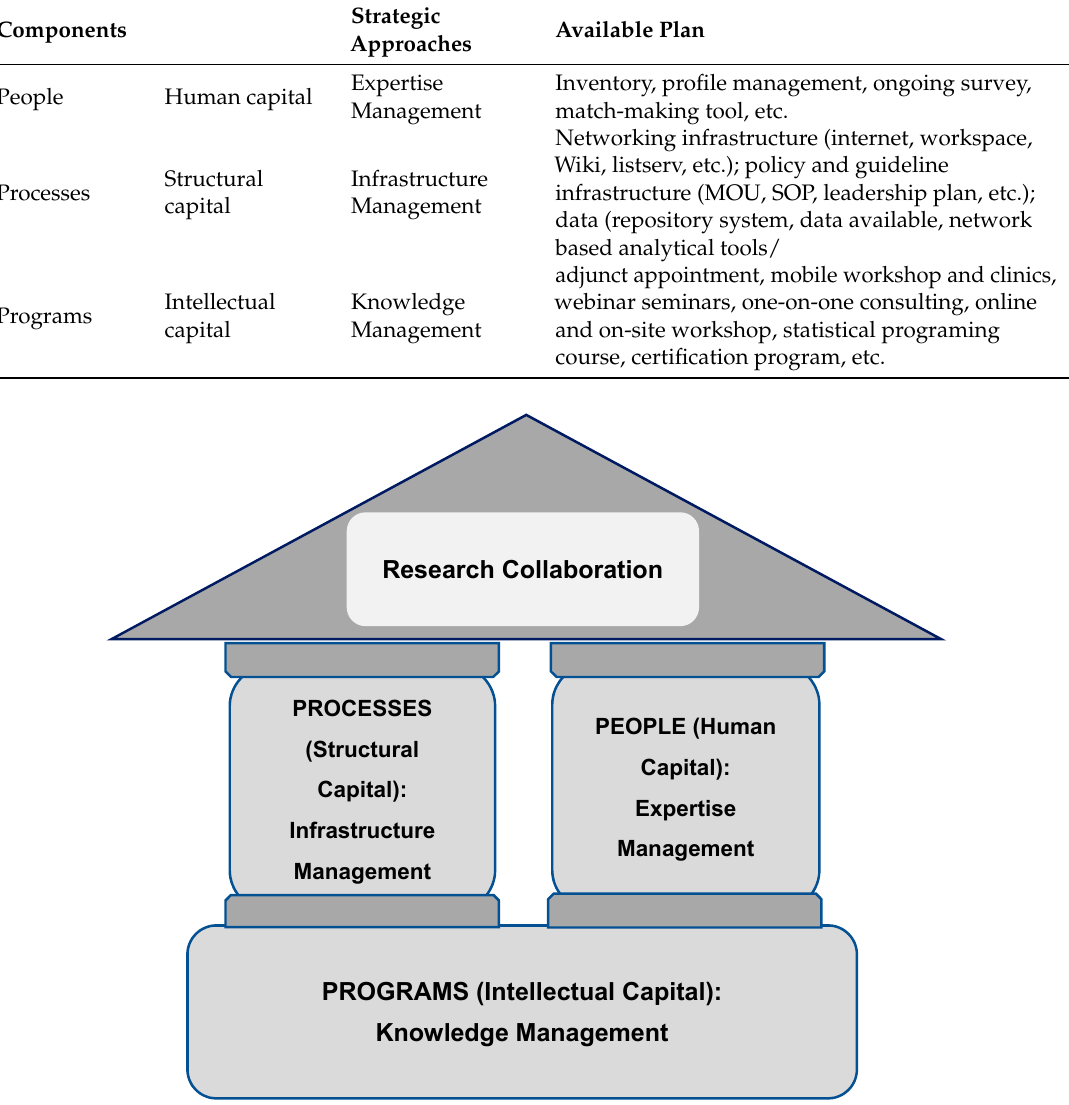
Figure 1. Key Components of the Strategic Approaches.